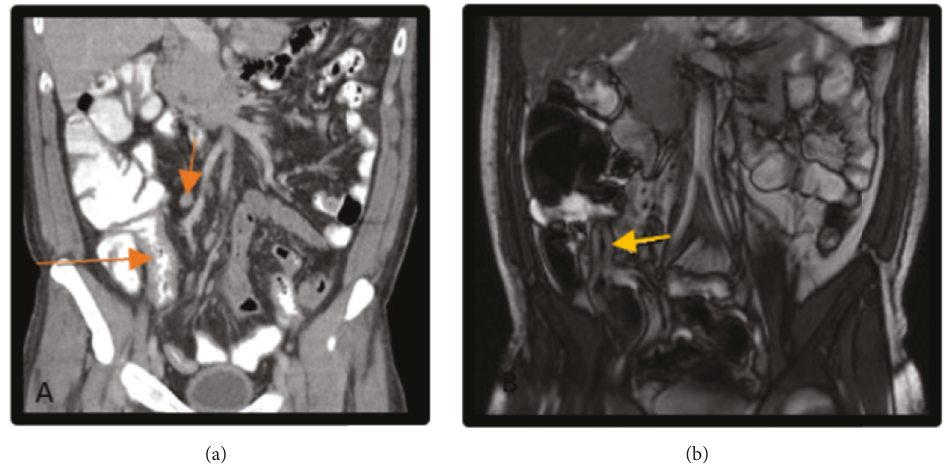
Figure 1: CT, MR Imaging. (a) Coronal CT, irregular wall thickening of the TI (long orange arrow), and mild RLQ lymphadenopathy (short orange arrow). (b) MRE, wall thickening of TI (yellow